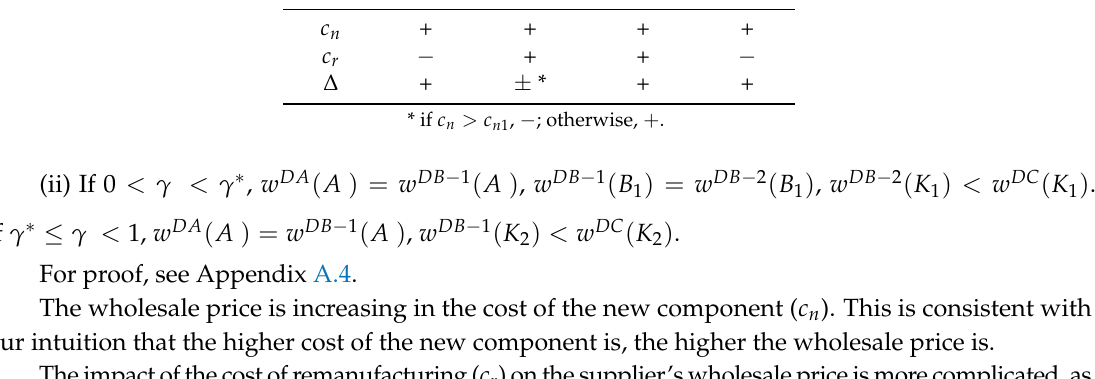
Table 5. Sensitivity analysis of the supplier’s optimal wholesale prices. Parameter w